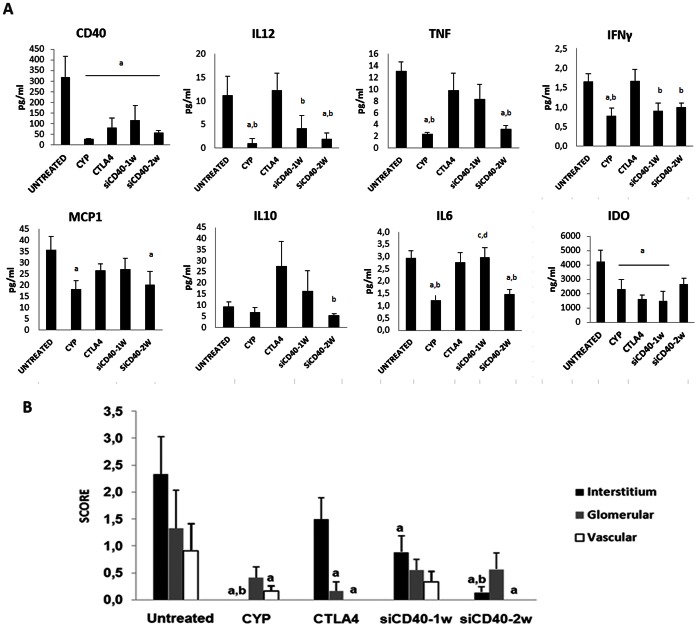
Systemic circulating inflammatory cytokines and local CD40 immunostaining.A) Lupus nephritis promoted over-expression of CD40 protein in serum, this immune modulatory protein was reduced in all therapies. Lupus nephritis also induced the increase in other inflammatory cytokines, treatment with siRNA anti CD40 reduced some of them. B) Immune localization and quantification of CD40 protein in different kidney compartments, Chol-siRNA reduced CD40 protein, especially in interstitial cells and vessels. Data are expressed as mean±SEM. a p<0.05 vs untreated; b vs CTLA4, c vs CYP and d vs siCD40-2w.